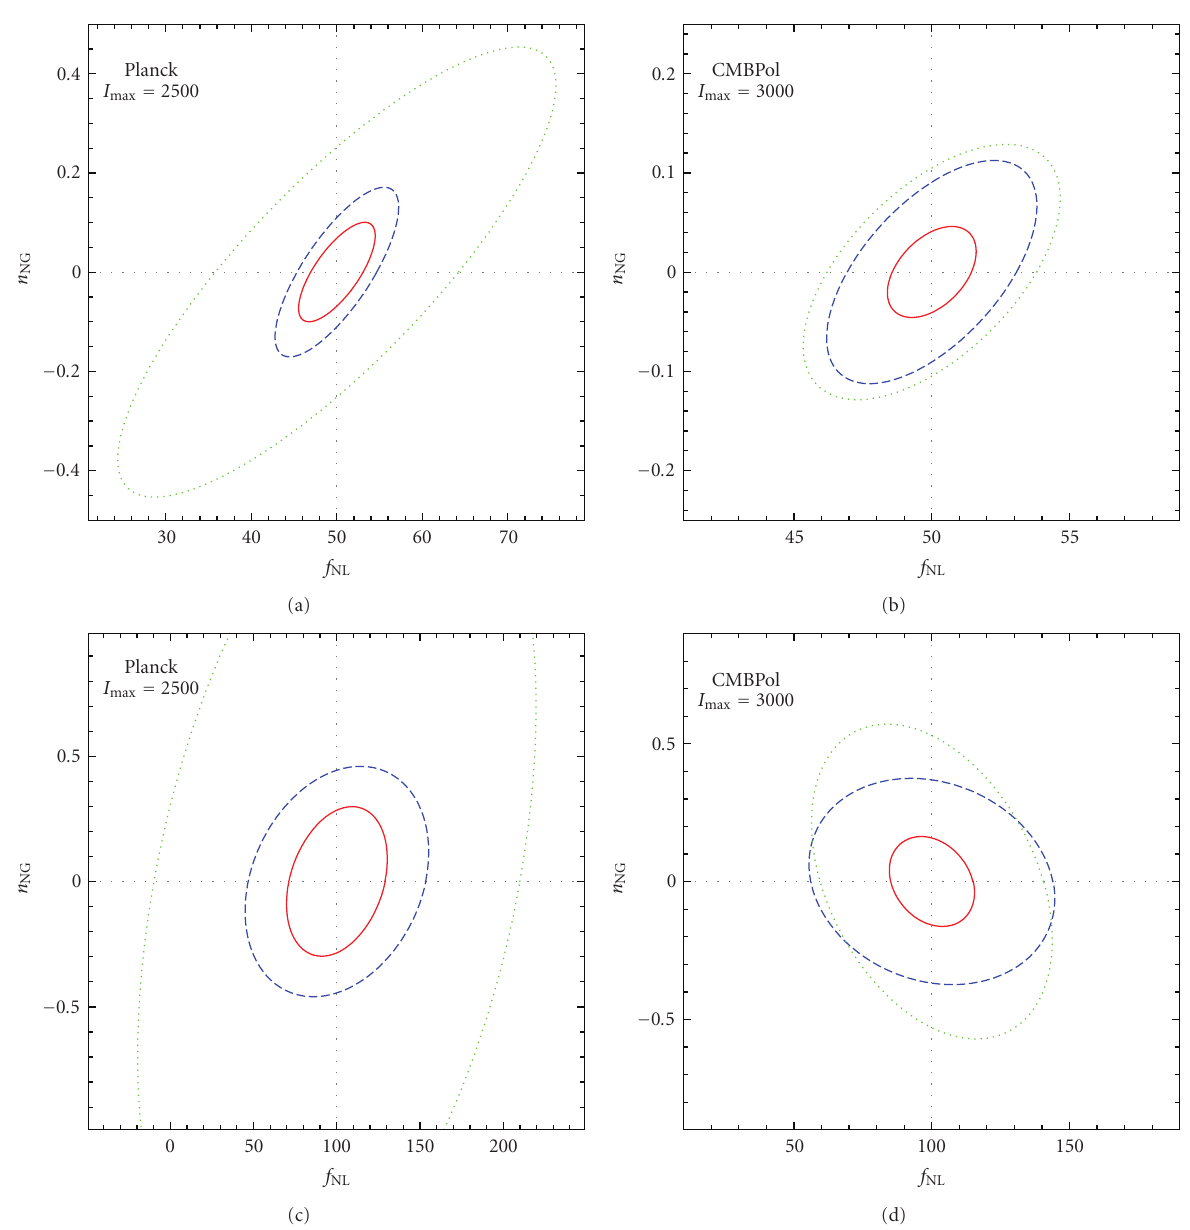
Figure 8: 1- σ constraints on f NL and n NG for local (a) and (b) and equilateral model (c) and (d) assuming k p = 0 . 04 Mpc − 1 and fiducial values f NL = 50, n NG = 0 for the local case and f NL = 100, n NG = 0 for the equilateral case. Dashed lines correspond to the limits from the temperature information alone, dotted lines to polarization ( EEE ), while the continuous lines correspond to all bispectrum combinations. We consider Planck (a) and (c) and CMBPOl-like (b) and (d) CMB